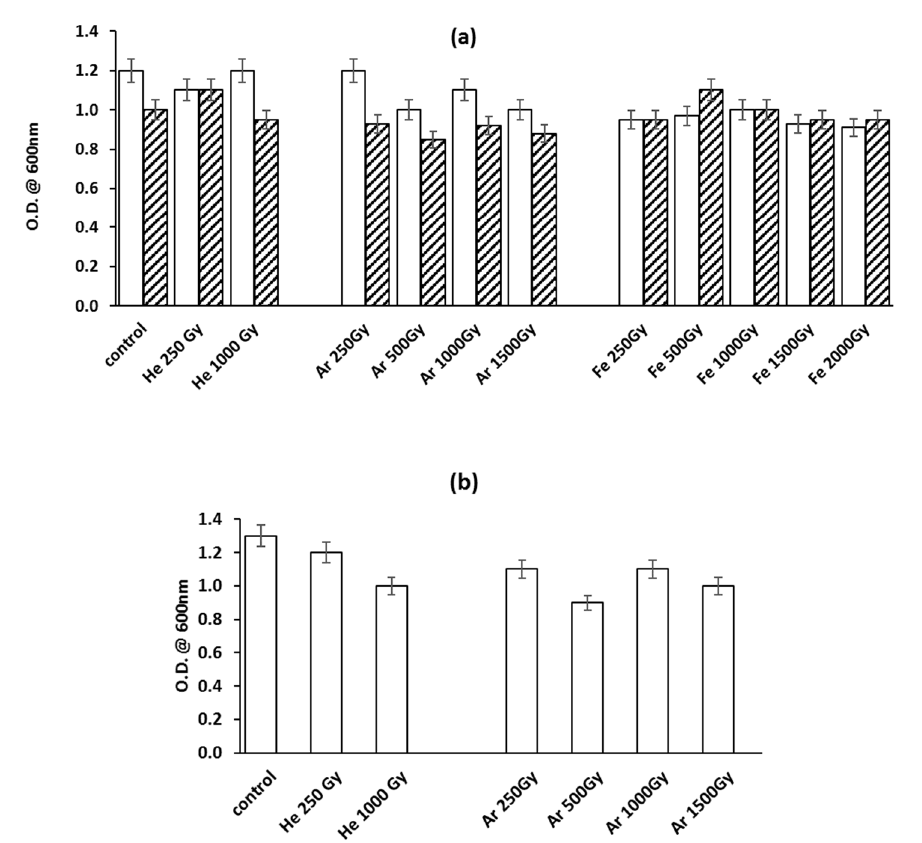
Figure 1. Haloterrigena hispanica ’s vegetative cells survival after HZE irradiation: ( a ) dried cells irradiated with He, Ar, and Fe ions; ( b ): cells in isotonic solution, irradiated with He and Ar ions (legend: O.D.: optical density at 660 nm; open bars: O.D. 1 month after irradiation; dashed bars: O.D. 1 year after irradiation).